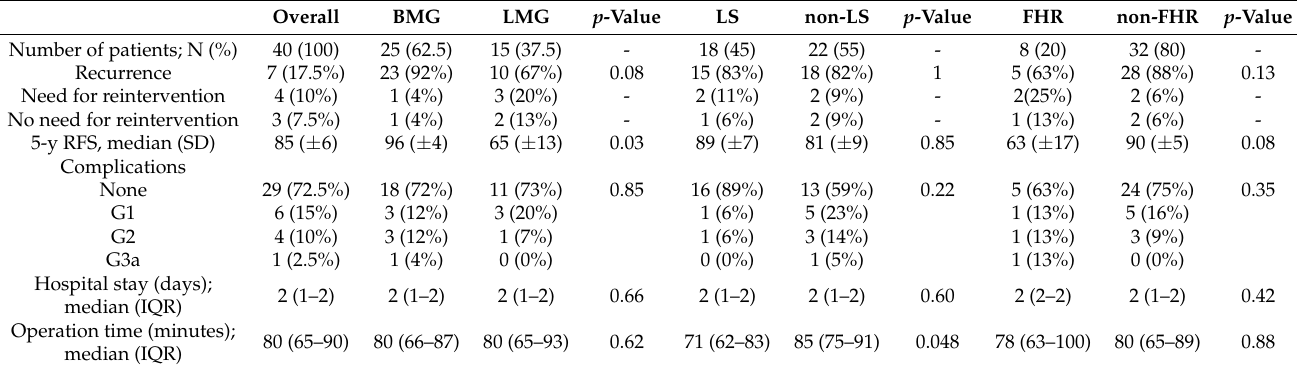
Table 2. Outcomes of Asopa’s technique for meatal strictures.